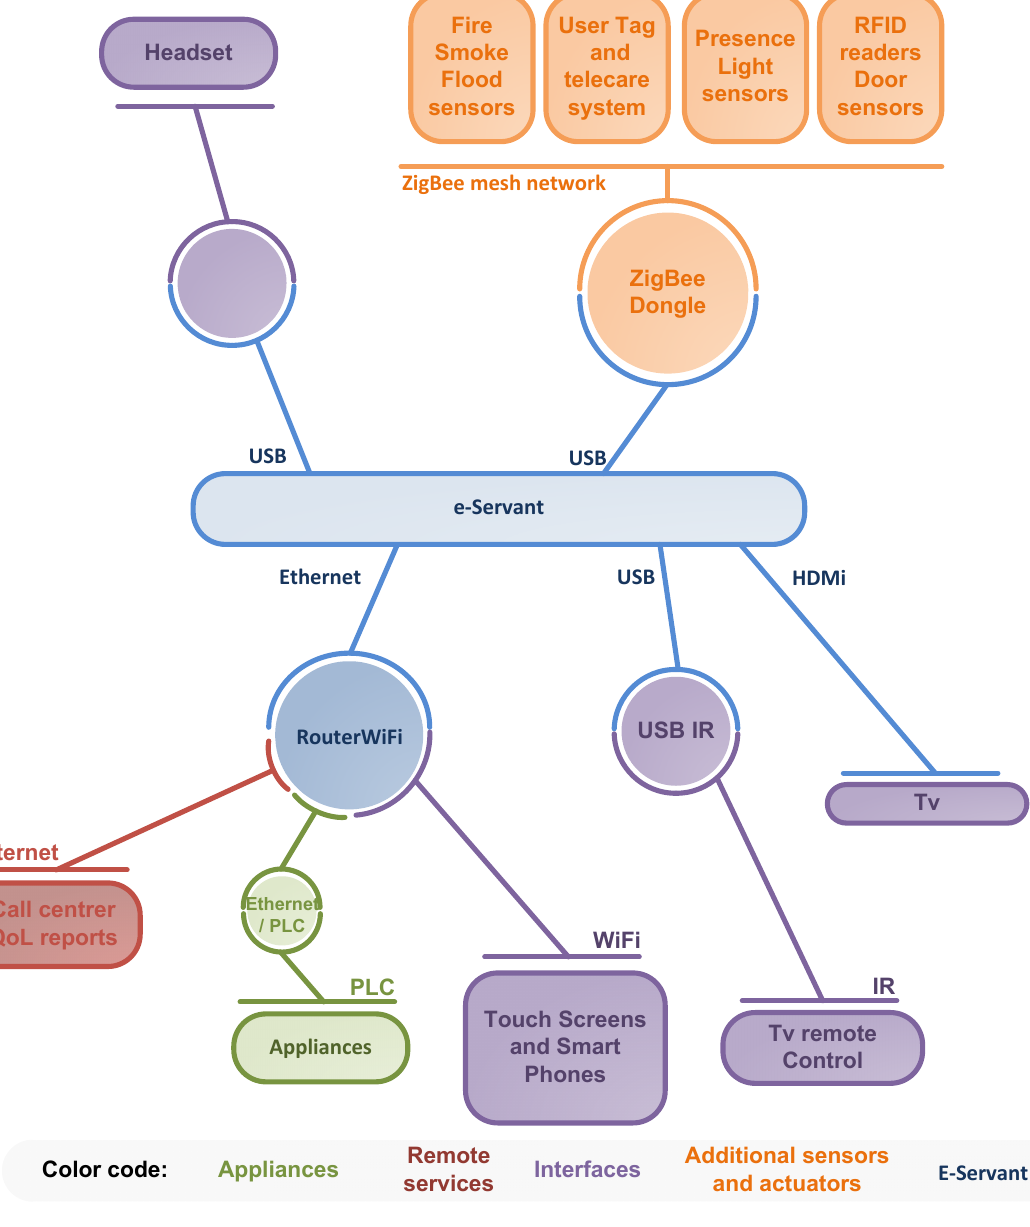
Figure 2. Communication diagram for context interaction in the Smart